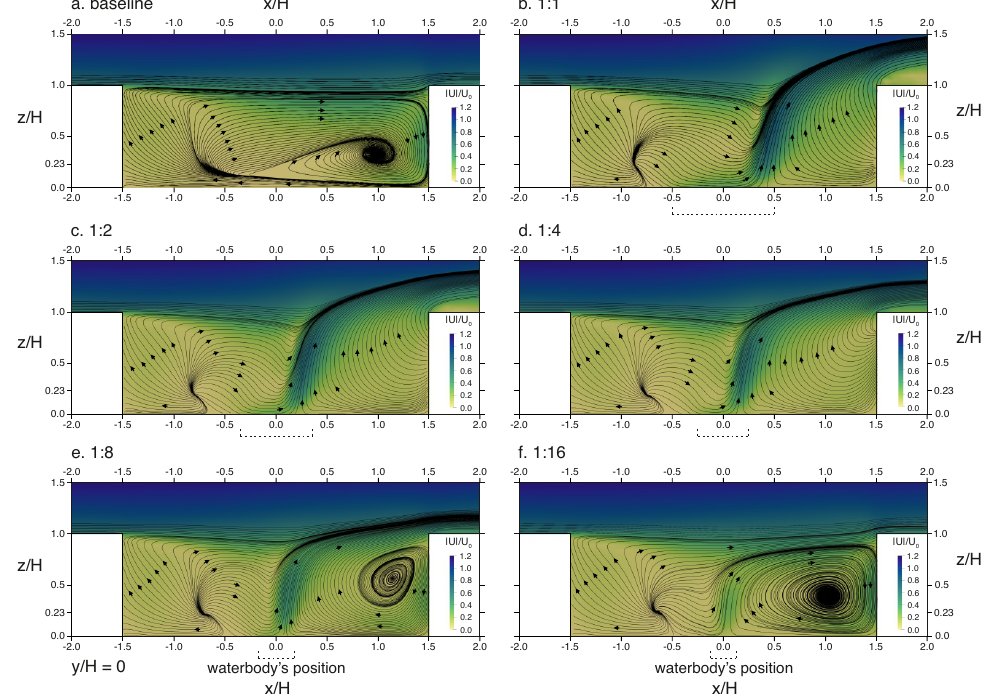
Figure 4. Velocity streamlines for the cases with a warmer water body ( ∆ T = + 2 K) of different size over a vertical plane at y / H = 0 in the open square ( − 1.5 ≤ x / H ≤ 1.5). Normalised velocity magnitude is depicted spatially in the background: ( a ) baseline scenario; ( b ) original size ( S_1:1 ); ( c ) half the original size ( S_1:2 ); ( d ) a quarter of the original size ( S_1:4 ); ( e ) one-eighth of the original size ( S_1:8 ); ( f ) one-sixteenth of the original size ( S_1:16